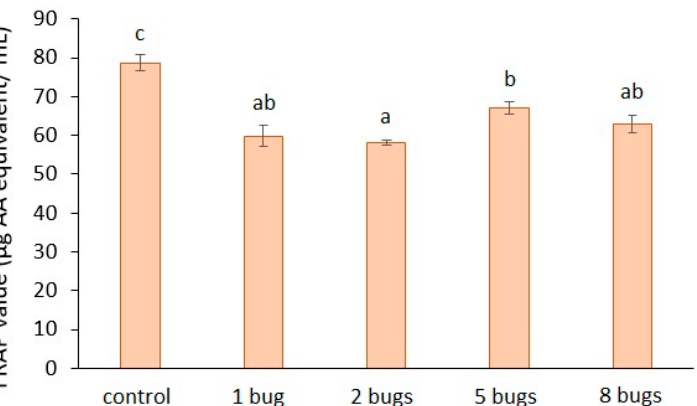
Figure 5. Antioxidant capacity of bug-infested tomato mesocarp. The presented results are the averages of three independent measurements, and the bars represent the ± standard deviation. a, b, c: Small letters indicate significant difference ( p ≤ 0.05) between the means of different treatments.